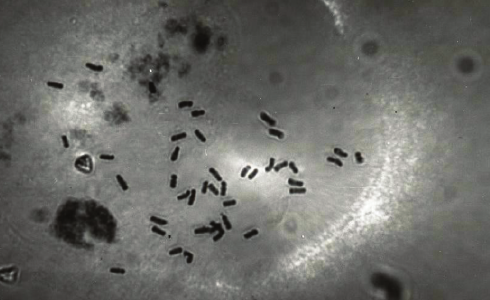
Figure2:( 10×40 ), 2𝑛 = 6𝑥 = 42 chromosomesbelongingtosample 419K of P. pseudo orientale collected from Dogubayezit-Igdir Road and Agri province, Turkey, pretreated with 0 ∘ C melting ice for 24 hours.